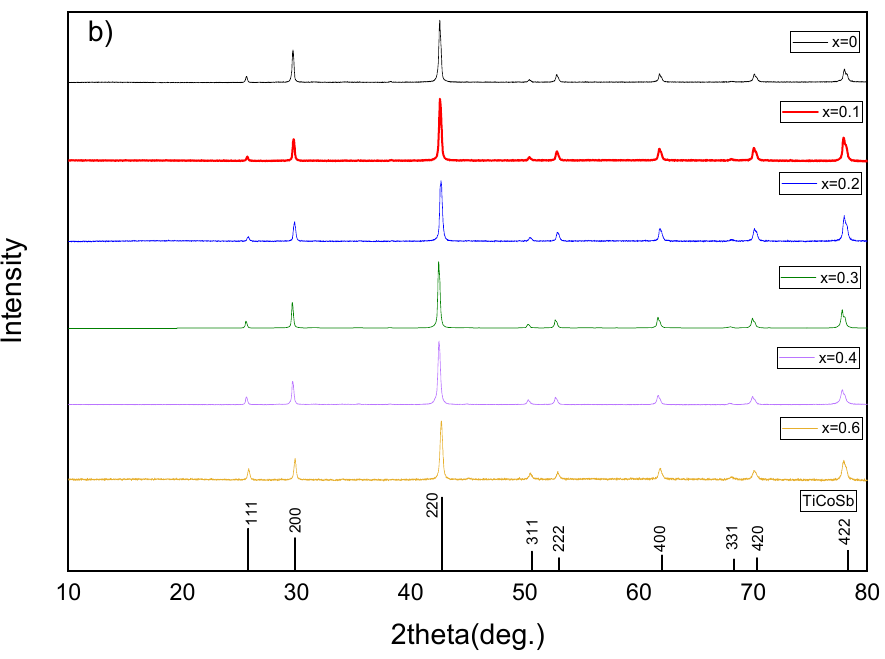
Figure 1. ( a ) X-ray powder diffraction patterns of Hf 0.6-x Zr x Ti 0.4 CoSb 0.8 Sn 0.2 powders prepared by 6 h mechanical alloying; and ( b ) the X-ray powder diffraction patterns of hot-pressed Hf 0.6-x Zr x Ti 0.4 CoSb 0.8 Sn 0.2 pellets and the theoretical pattern of TiCoSb.